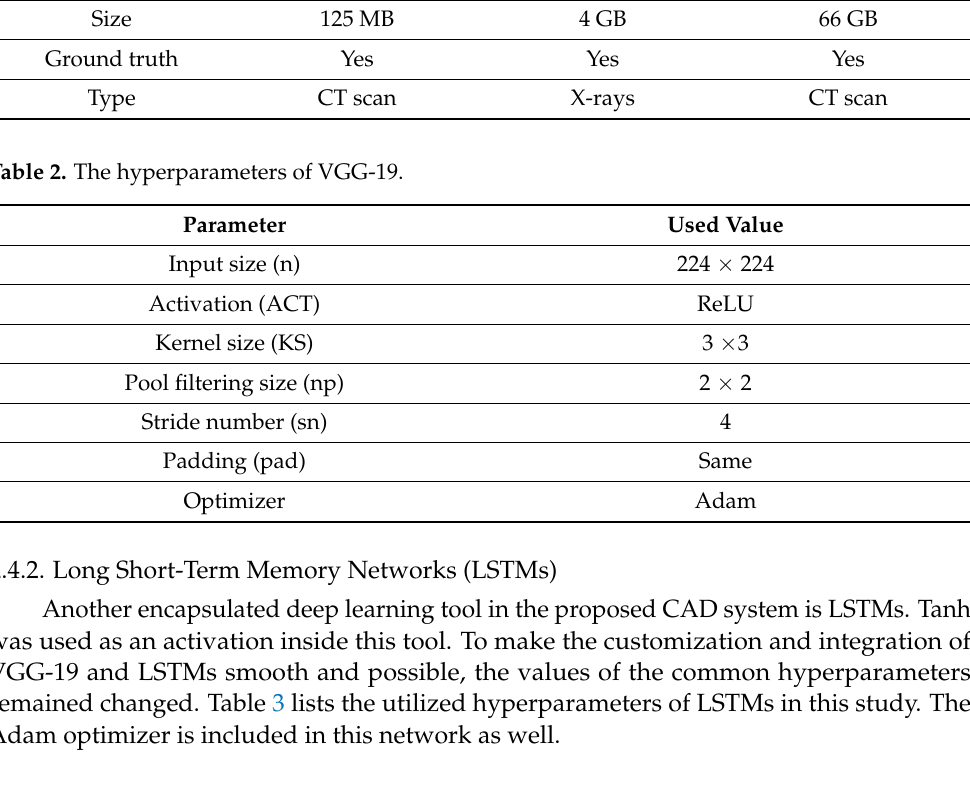
Table 3. LSTMs’ hyperparameters and their